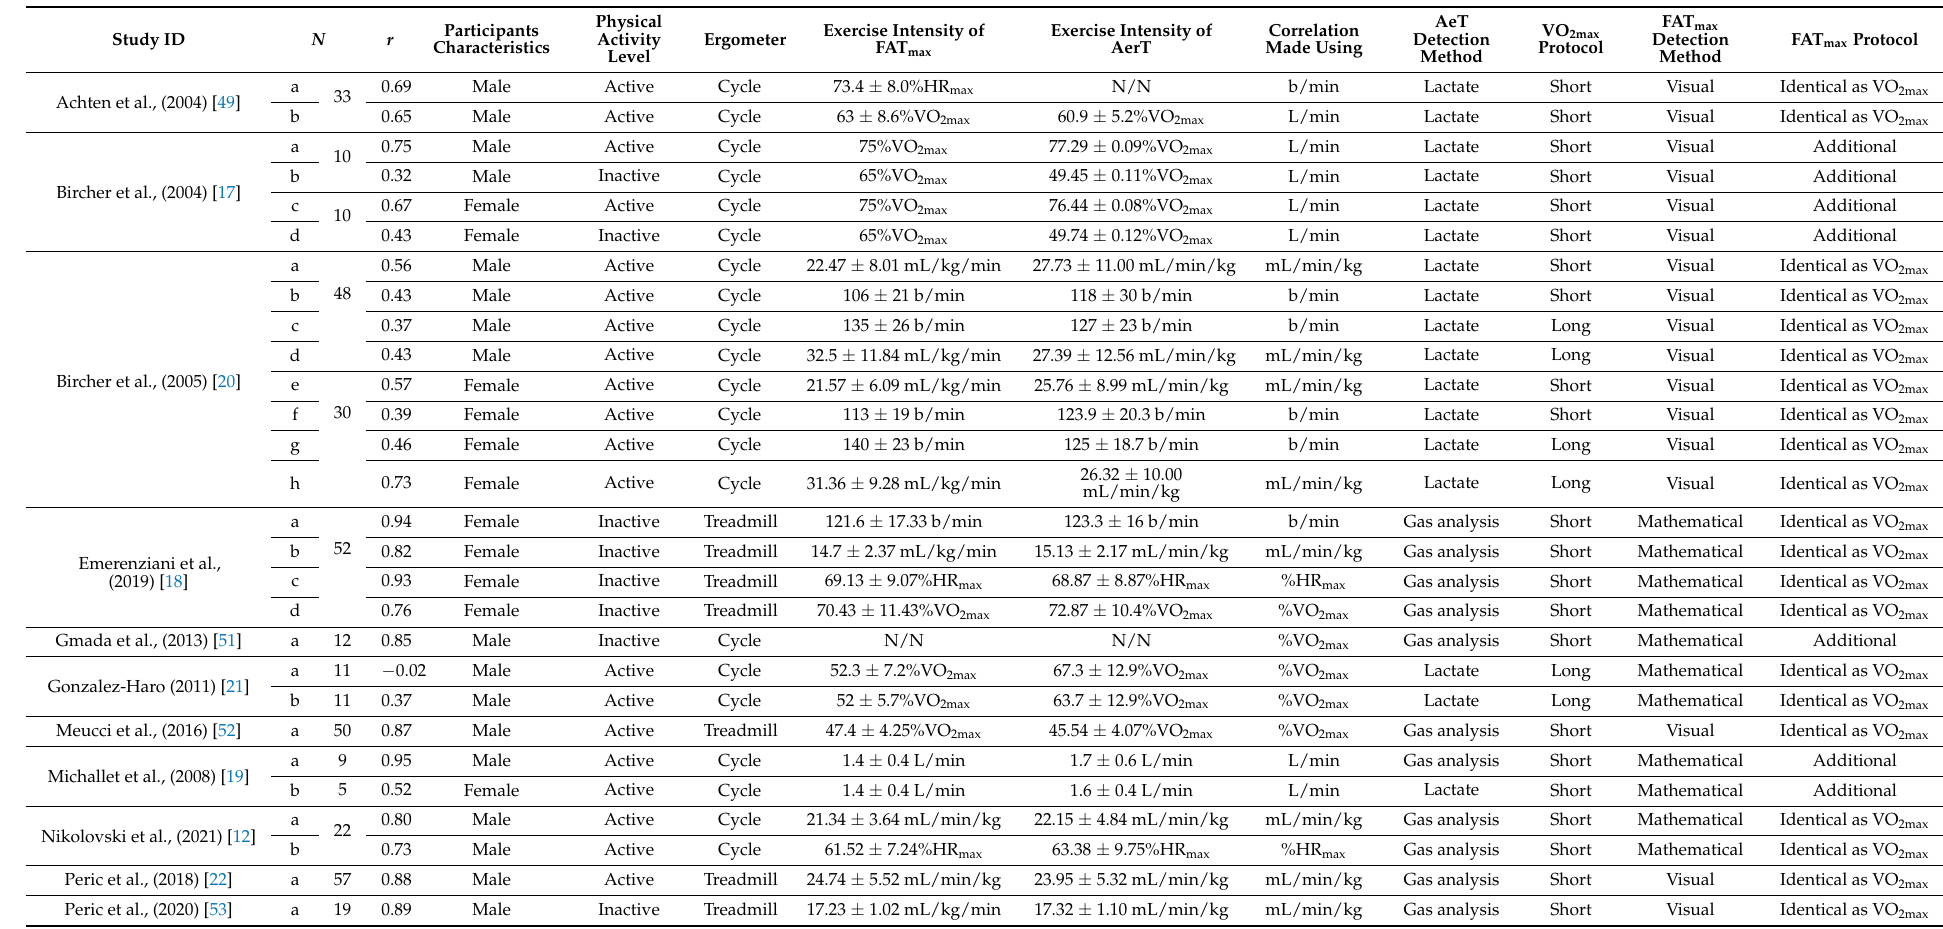
Table 1. Descriptive statistics of included studies with identified categorical moderator variables, categorised by differences in characteristics of the studies (methodological diversity) and study populations (clinical